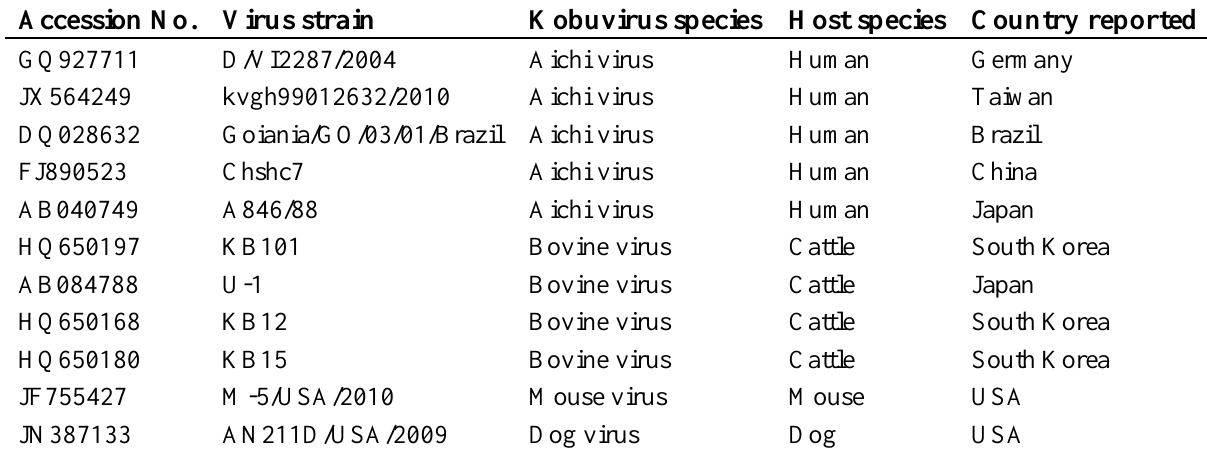
Table 2. Kobuvirus strains used in this